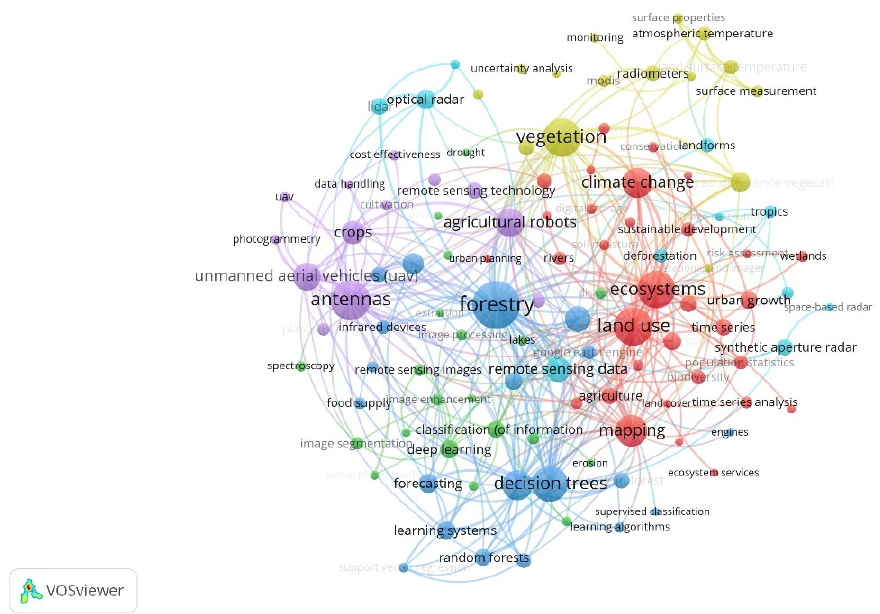
Figure 6. VOSviewer results of co-occurrences in papers published in Remote Sensing in 2021 with key terms “sustain” or “sustainable development”: see Appendix A.2 for details.